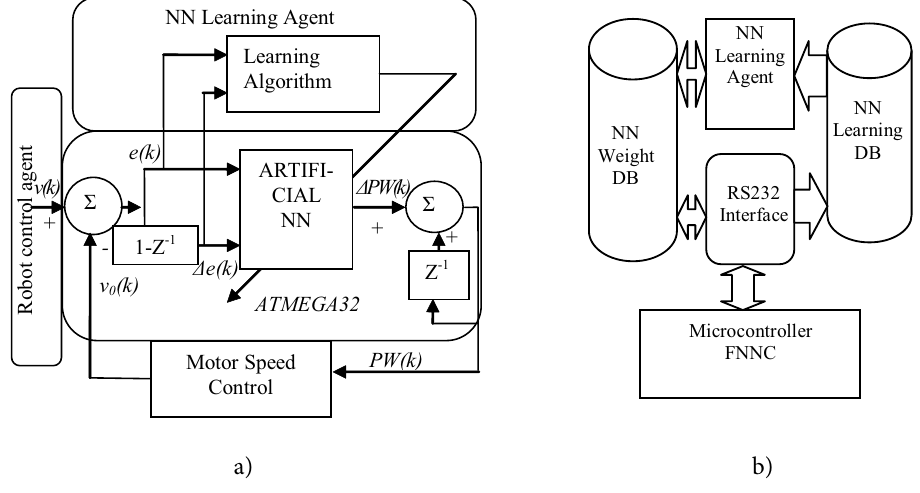
Fig. 2. Multi-agent based adaptive robot motor speed control system: a) Modifi ed agent based adaptive FNNC-type DC motor speed controller, according to (Rubaai et al. 2005), b) Agent-based NN learning system (Gricius et al.